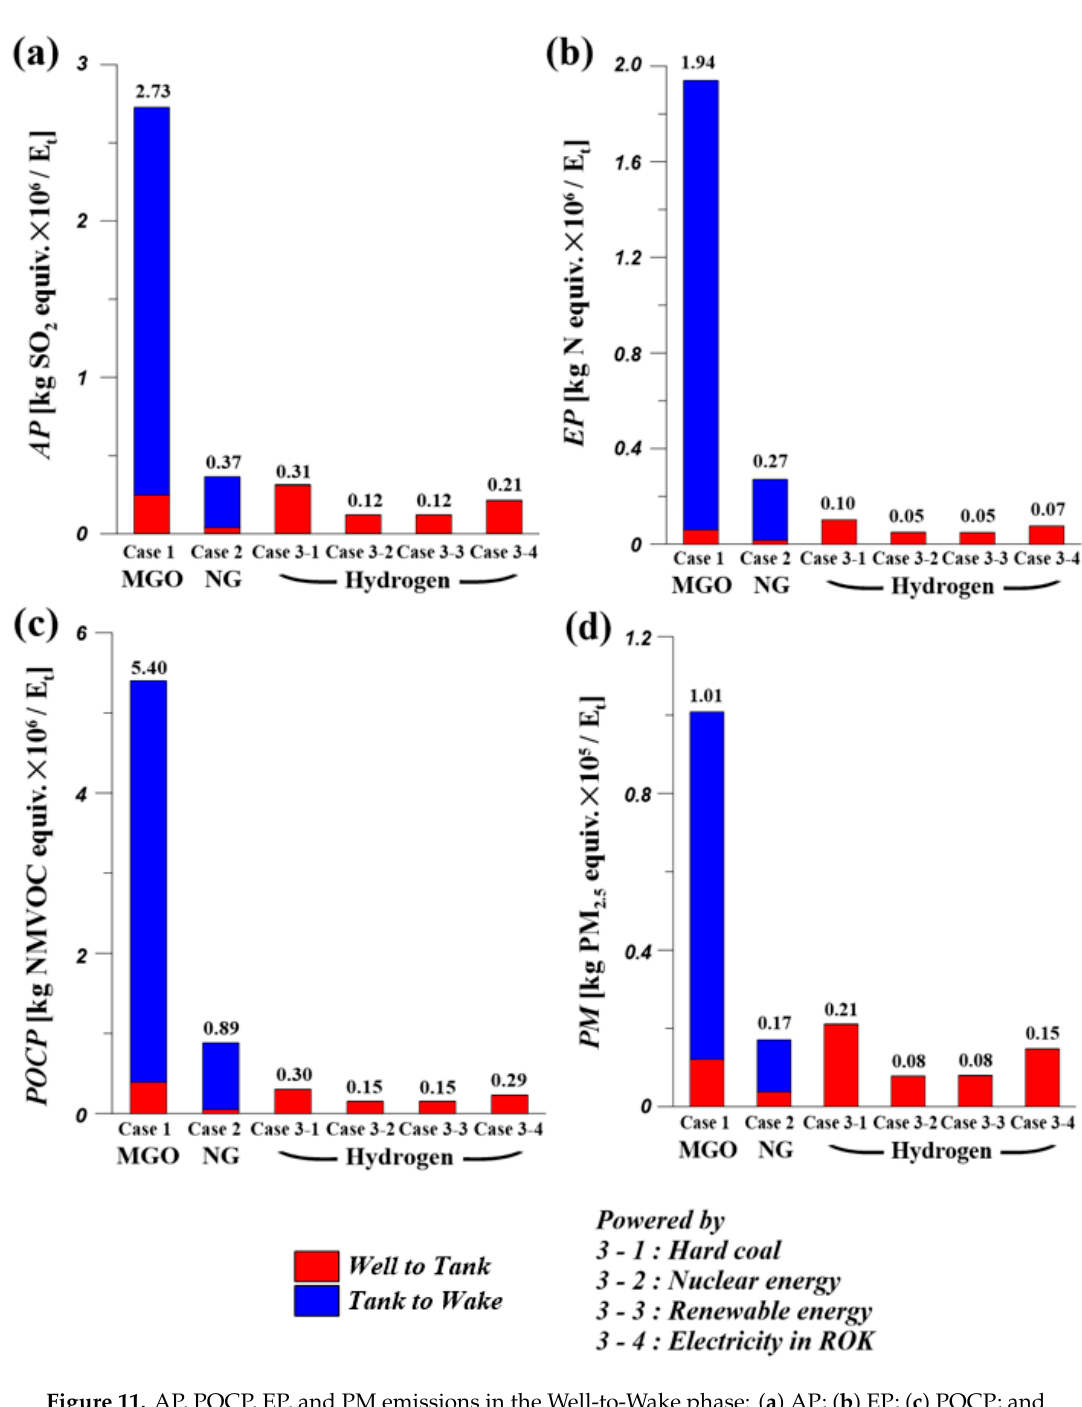
Figure 11. AP, POCP, EP, and PM emissions in the Well-to-Wake phase: ( a ) AP; ( b ) EP; ( c ) POCP; and ( d ) PM.